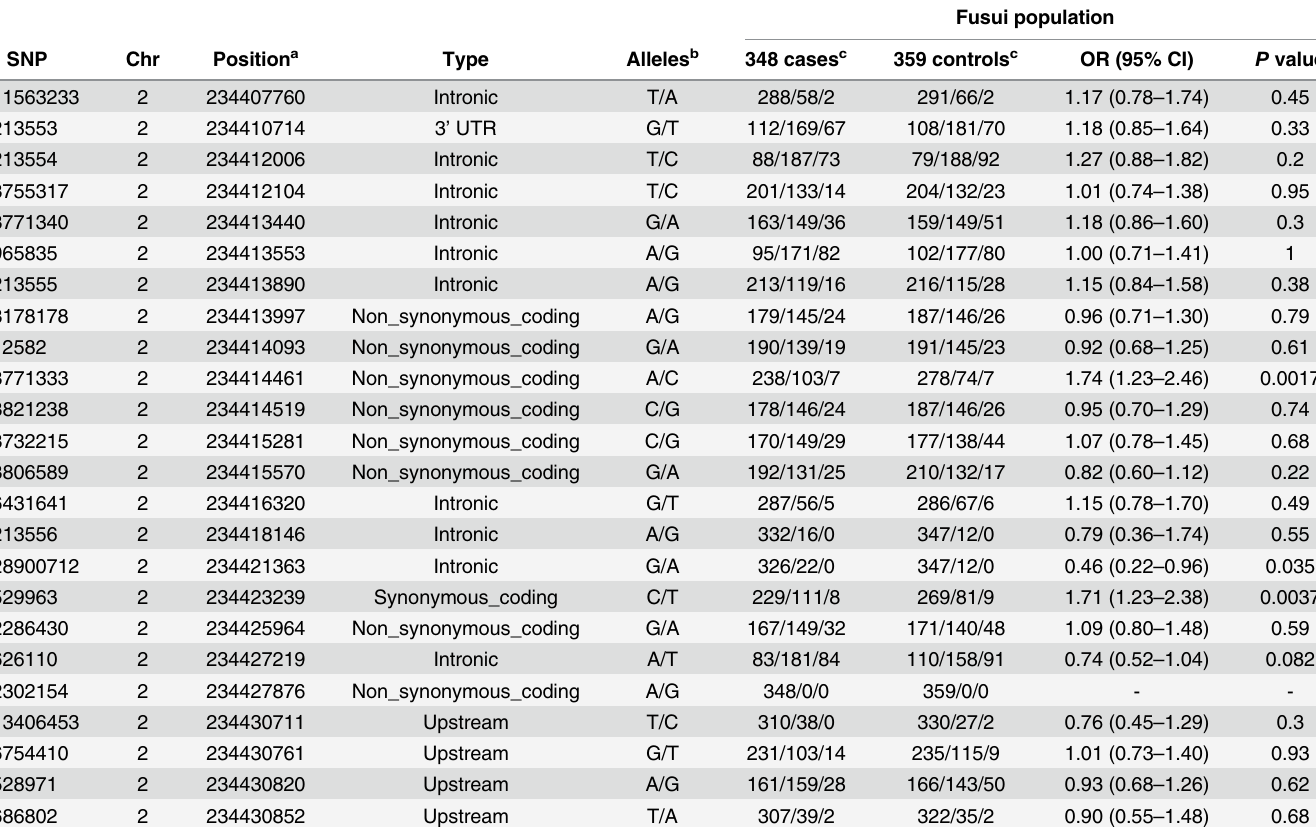
Table 1. Summary of the association results of the 24 polymorphisms in the Fusui